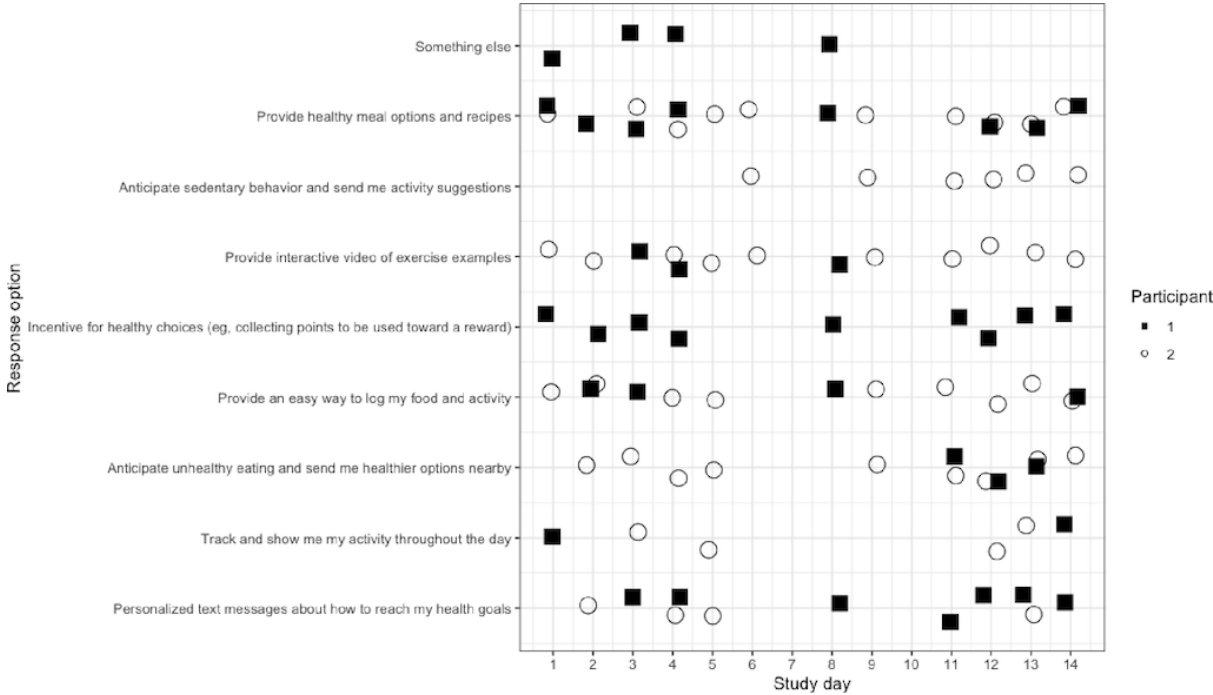
Figure 2. Responses on dynamic needs and preferences for healthy eating from 2 study participants over the 2-week study